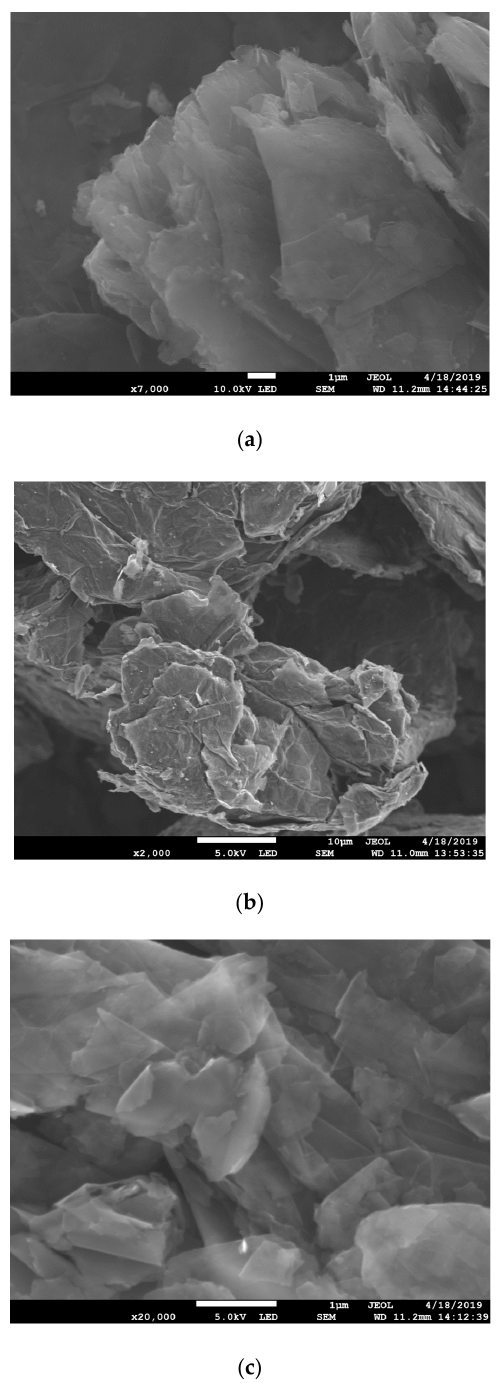
Figure 1. SEM images of ( a ) expanded graphite (EG), ( b ) graphene oxide (GO), ( c ) and graphene (GR) used in this study.